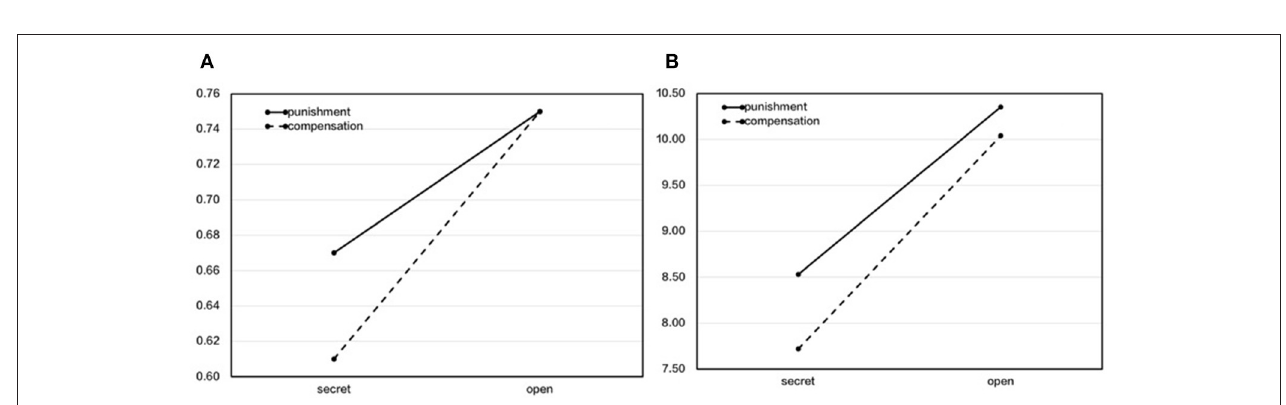
FIGURE 3 | The difference in transfer rates and amounts between punishment and compensation under the contexts of secret and open when participants were not free to choose. (A) Transfer rate. (B) Transfer amount.